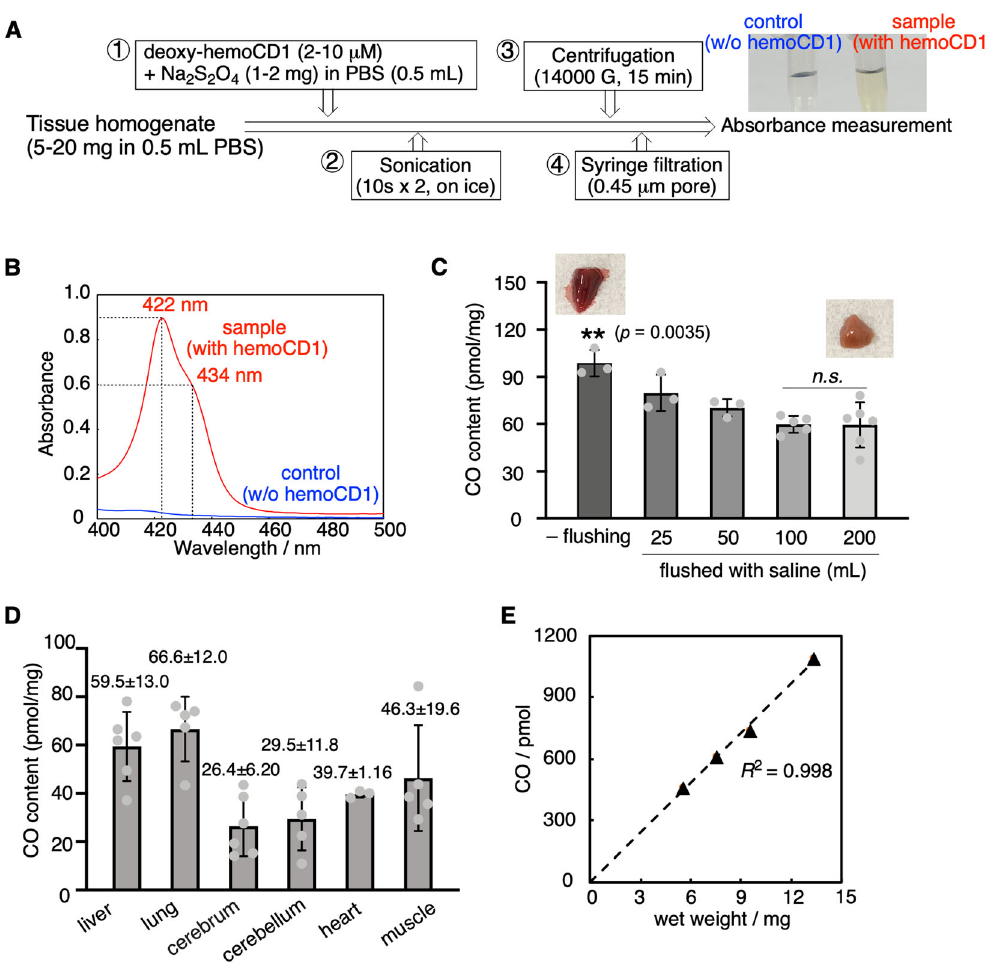
Fig. 4 Quanti fi cation of CO in rat tissues. A Experimental procedure describing the various steps of the hemoCD1 assay for measuring CO in tissue samples collected from different rat organs. The picture shows clear supernatant solutions of tissue sonicates without (control) and with deoxy-hemoCD1. B Typical representative spectra of supernatant solutions of liver sample and control obtained at the end of the hemoCD1 assay. C Amounts of CO quanti fi ed in liver tissues without ( – ) or following fl ushing with 25 – 200 ml saline. Each bar represents the mean ± SD ( n = 3 – 6). Statistical signi fi cance, ** p < 0.01 versus 200 ml fl ushed organs; n.s. not signi fi cant. D Content of endogenous CO (pmol/mg, wet weight) detected in different organs using the hemoCD1 assay. Each bar represents the mean ± SD ( n = 6 for liver, n = 5 for lung, n = 6 for cerebrum, n = 5 for cerebellum, n = 3 for heart, and n = 5 for muscle). E Plot of the wet weight of liver tissue versus the amount of CO